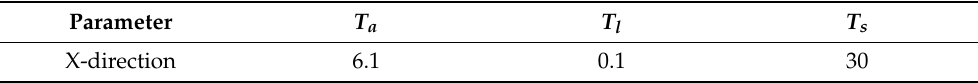
Table 3. Coefficient of the semicircular canal